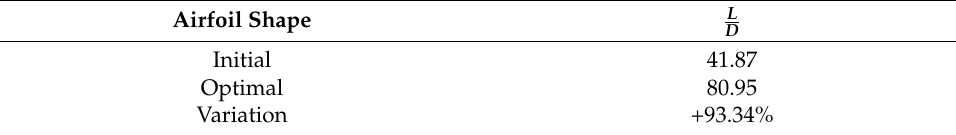
Table 9. The value of lift-to-drag ratio for the initial and optimal shapes (Test case